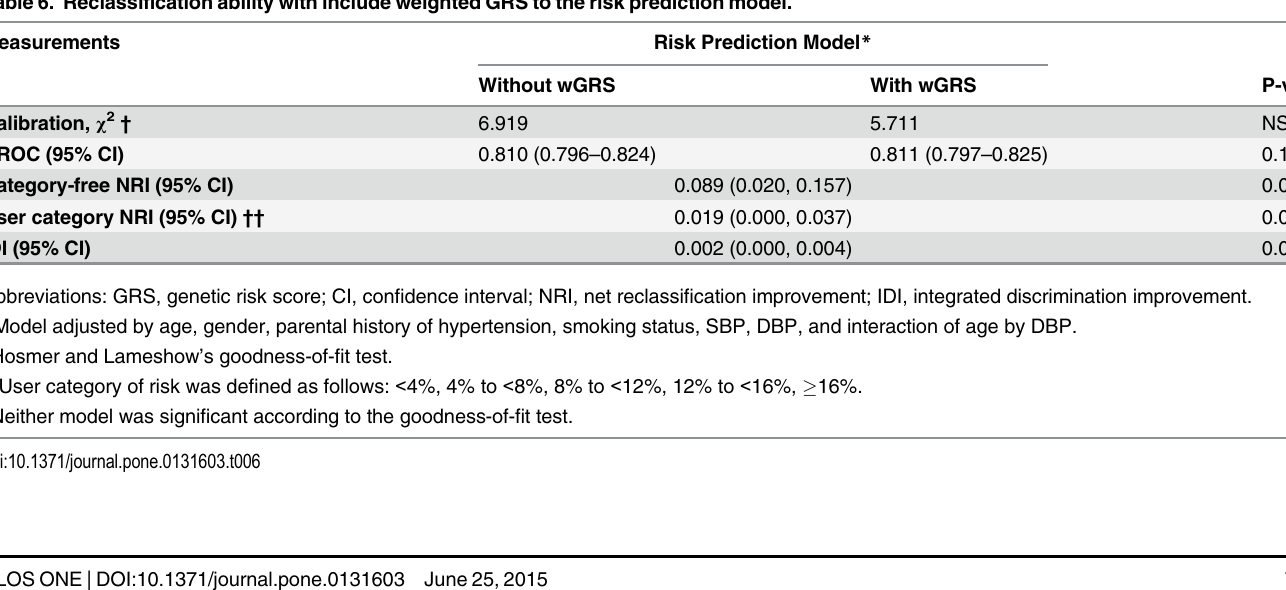
Table 6. Reclassification ability with include weighted GRS to the risk prediction